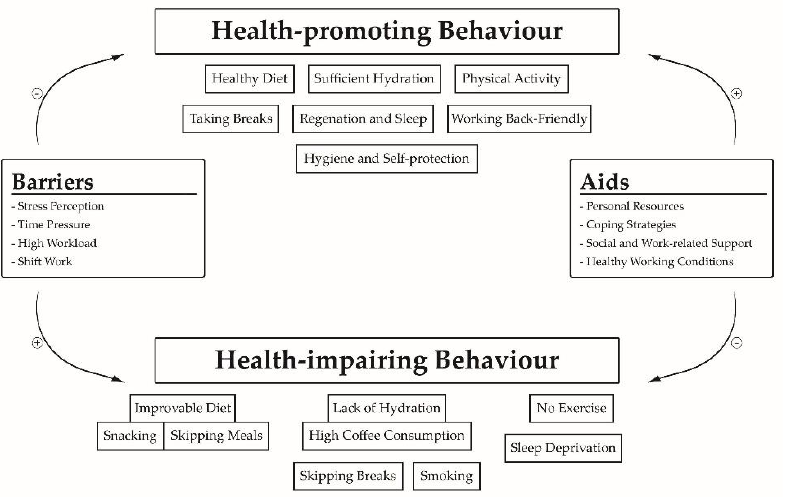
Figure 1. Outpatient caregivers’ health behaviour, as well as factors influencing health behaviour patterns.